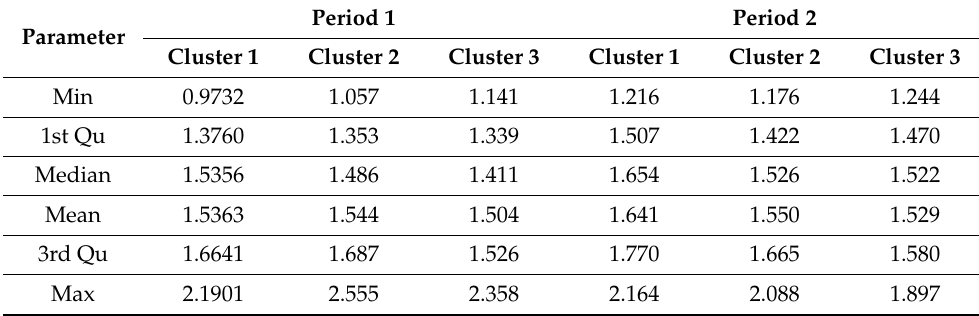
Table 20. Descriptive statistics of the THDu in phase L3 at the tested measuring point.